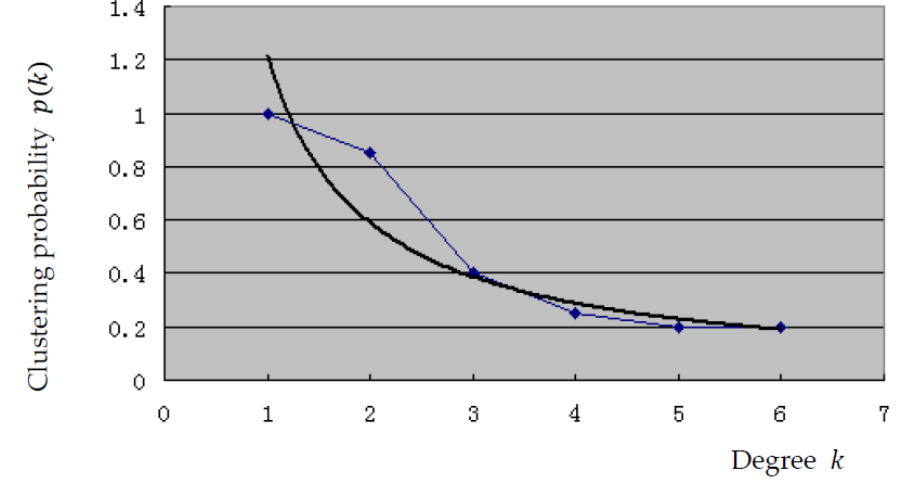
Figure 3. Relation between degree 𝑘 and its cumulative probability 𝑝(𝑘) .